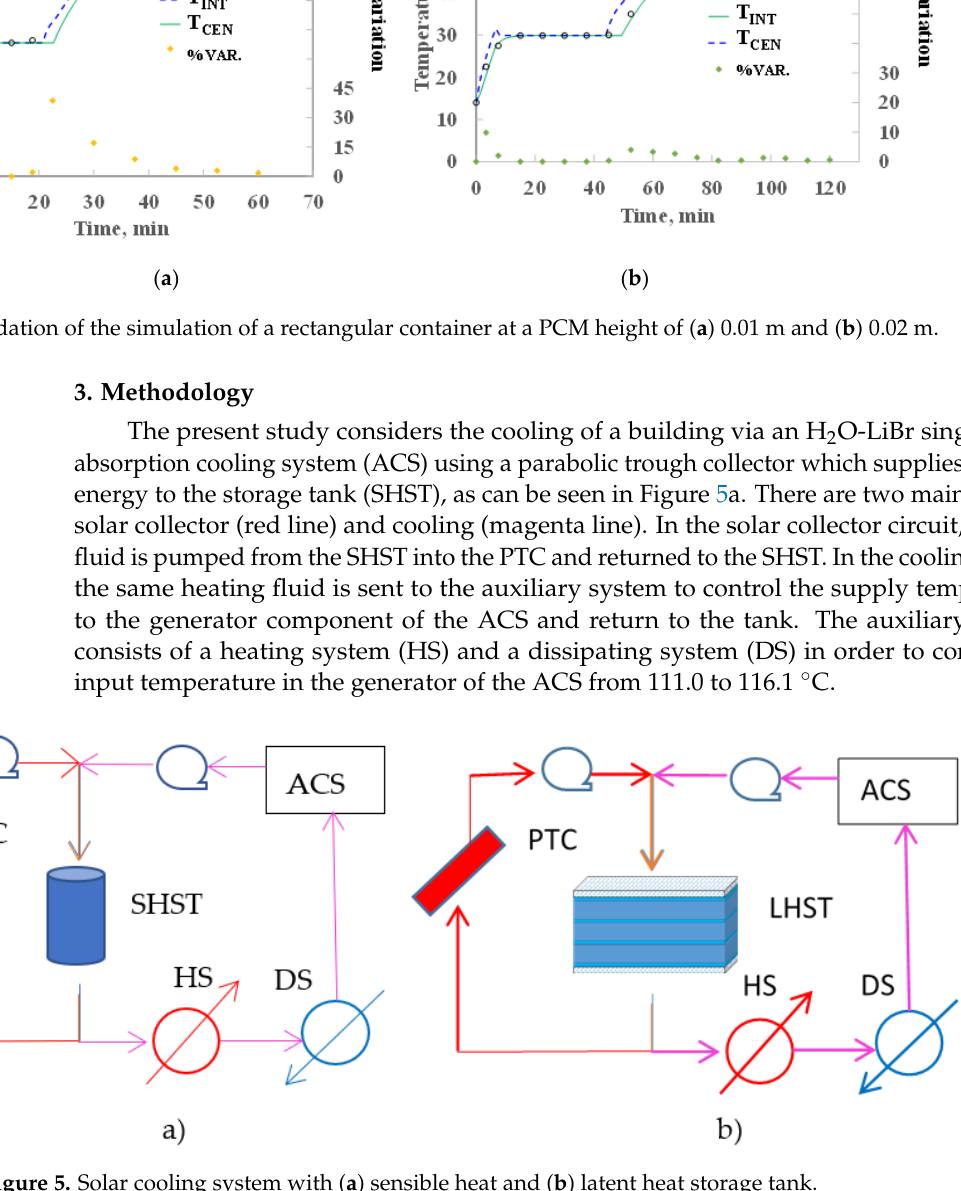
Figure 6. Solar cooling system with latent heat storage tank and a tempering valve. 3.1. Operation Time An analysis of the environmental conditions was carried out in order to select the time of operation of the ACS. Type 15-2 (weather data) was built in the TRaNsient SYstem Simulation (TRNSYS) software to simulate the environmental conditions of Temixco City, Morelos, Mexico. A typical week in summer was selected from 1996 to 2164, as Figure 7 shows. The environmental temperature (T ENV ) oscillates from around 32 to 20 °C (blue line). A building was simulated in a previous work [14]; some building characteristics are shown in Table 2. The maximum cooling demand (red line) was 8 kW. In addition, the figure shows that the cooling heat load is somewhat lower on the first day than on the others, which presents the opportunity to store energy in the storage tank.